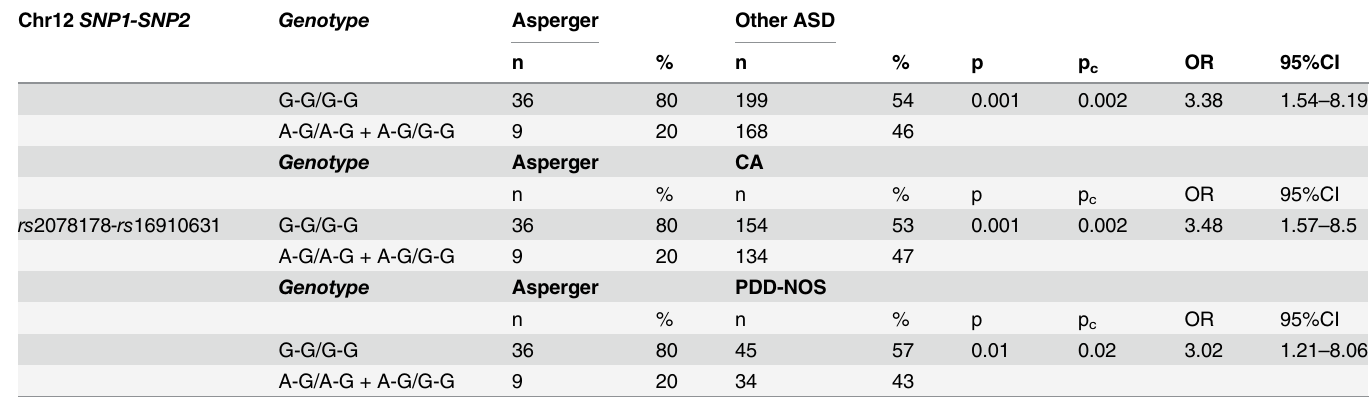
Table 5. Haplotypes distribution in patients with classical autism and Asperger and controls. Chr12